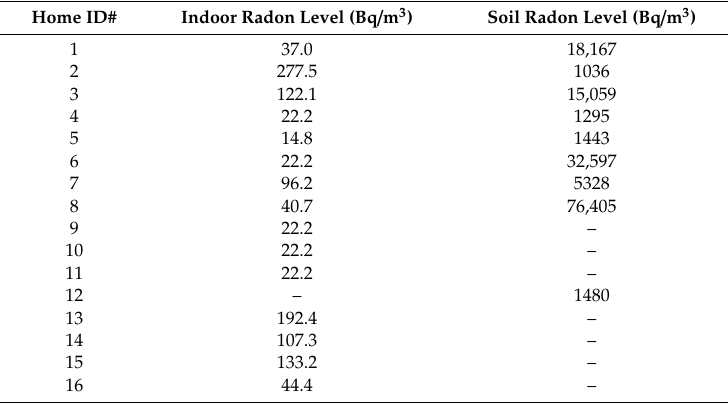
Table 2. Indoor and soil radon measurements by home